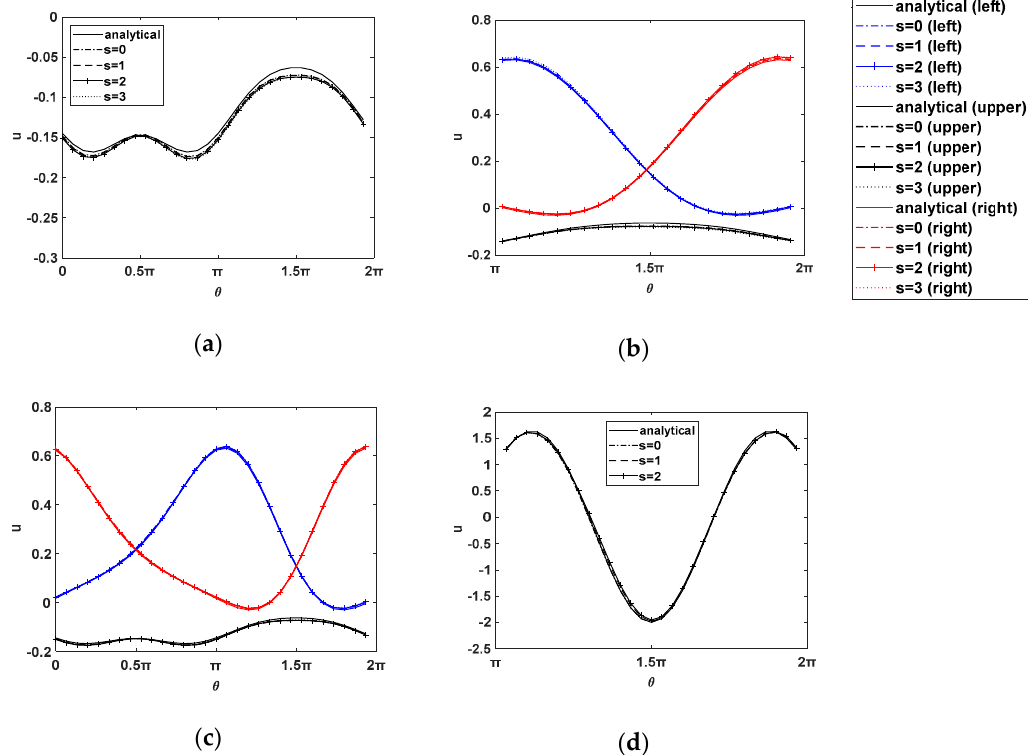
Figure 17. Comparison of numerical solutions along missing boundary obtained by various s : ( a ) unknown upper inner boundary; ( b ) three half unknown inner boundaries; ( c ) unknown inner boundaries; ( d ) half unknown outer boundary. Table 3. Comparison of maximal absolute errors (%) obtained by various s : (a) unknown upper inner boundary; (b) three half unknown inner boundaries; (c) unknown inner boundaries; (d) half unknown outer boundary.